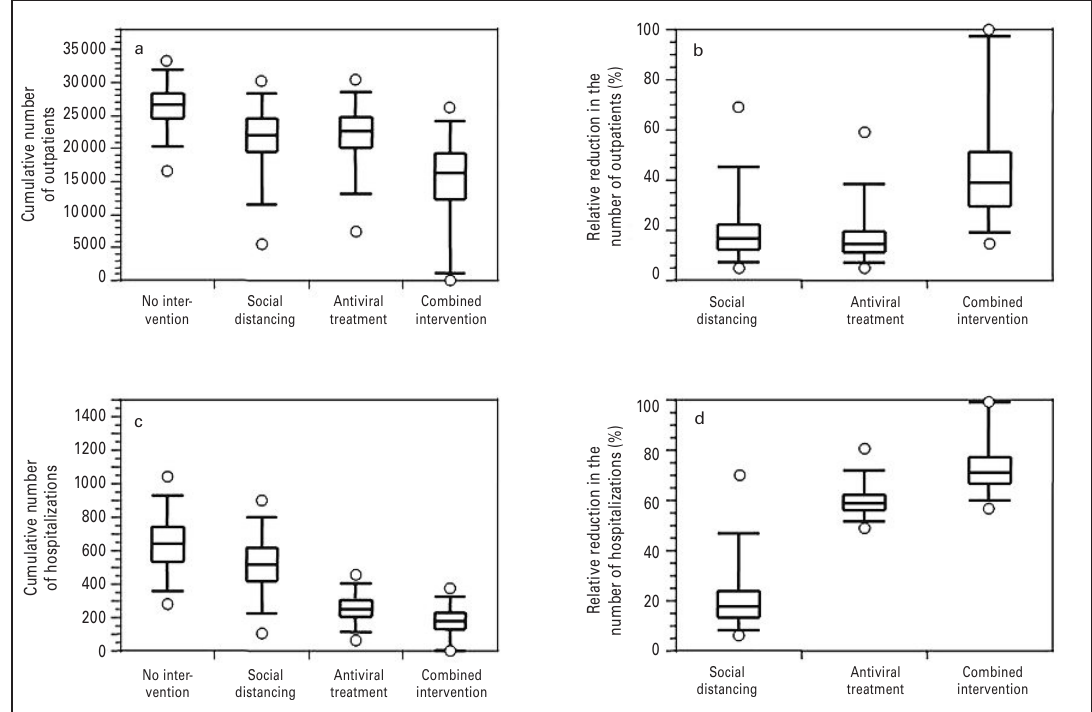
Discussion Due to the uncertainties in parameter esti- mates for Influenza, it is important to consider ranges of parameter values. Sampling random val- ues from reasonable intervals and using them in a